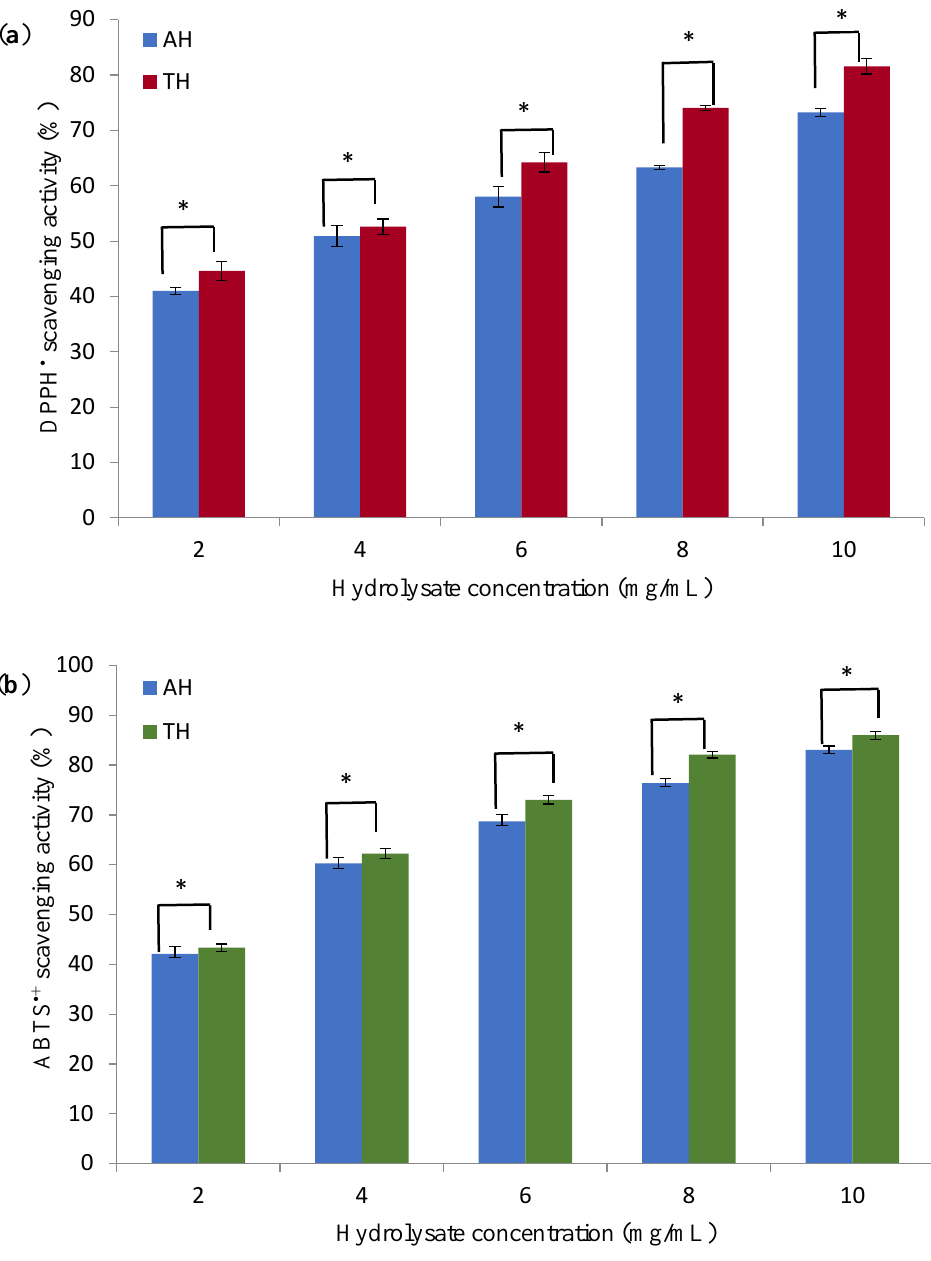
Figure 9. ( a ) DPPH • scavenging activity and ( b ) ABTS • + scavenging activity of peanut hydrolysates obtained under optimal conditions using alcalase (AH) and trypsin (TH). Data expressed as mean ± SD of triplicate determinations. (*) indicate significant differences at the same concentration with the different hydrolysates.